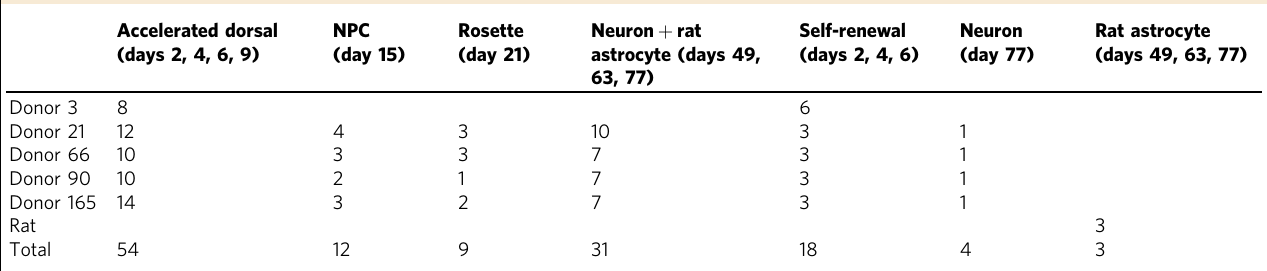
Table 1 Sample and cellular condition